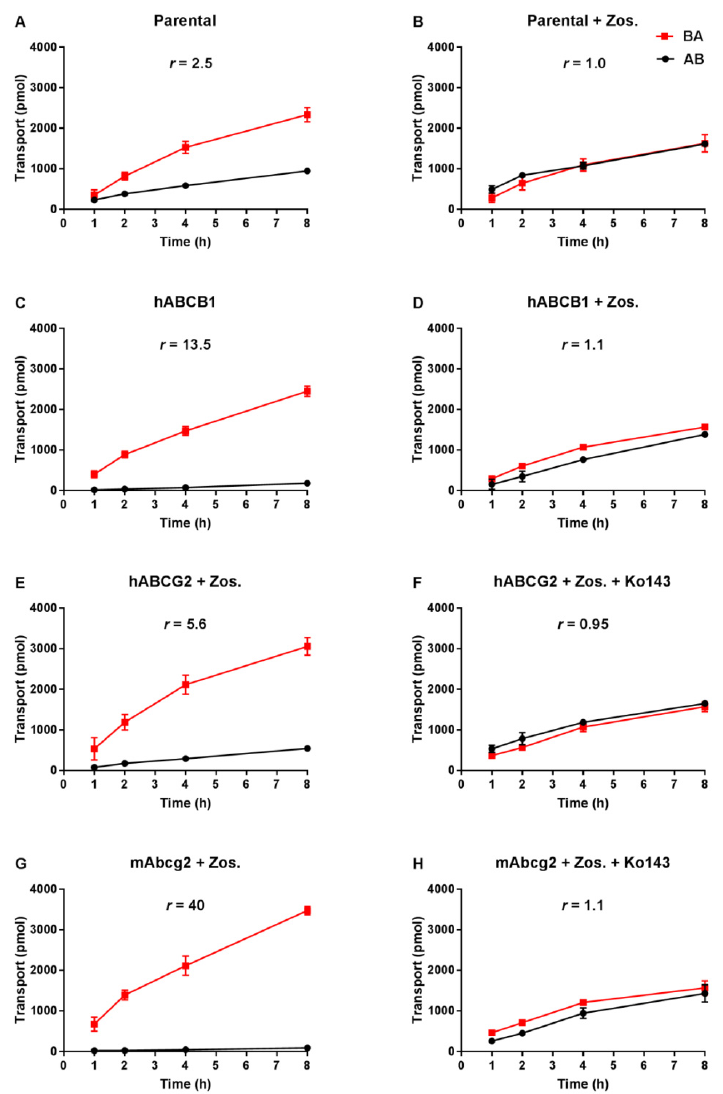
Figure 2. Transepithelial transport of repotrectinib (5 µM) assessed in MDCK-II cells either non- transduced ( A , B ), transduced with hABCB1 ( C , D ), hABCG2 ( E , F ) or mAbcg2 ( G , H ) cDNA. At t = 0 h, repotrectinib was applied in the donor compartment (either apical or basolateral) and the concentrations in the acceptor compartment at t = 1, 2, 4, and 8 h were measured and plotted as repotrectinib transport (pmol) in the graph (n = 3). B, D–H: Zos. (zosuquidar, 5 µM) was applied to inhibit human and/or endogenous canine ABCB1. F and H: the ABCG2 inhibitor Ko143 (5 µM) was applied to inhibit ABCG2/Abcg2-mediated transport. r , efflux transport ratio. BA ( ■ ), translocation from the basolateral to the apical compartment; AB ( ● ), translocation from the apical to the basolateral compartment. Points, mean; bars, S.D. Data are presented as mean ± S.D. (n = 3).